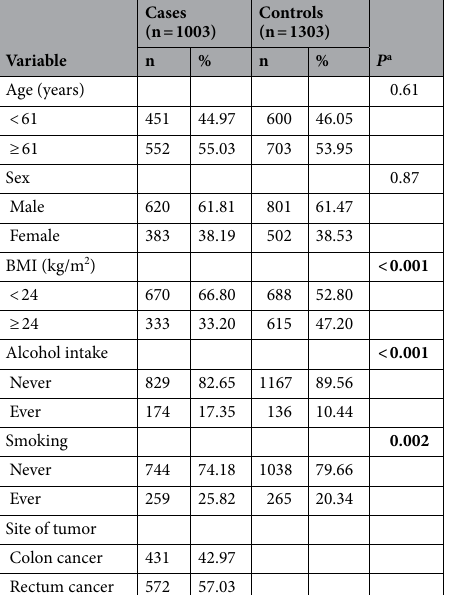
Table 1. The demographic variables of CRC patients and controls. BMI, body mass index. a Bold values are statistically significant ( P < 0.05).